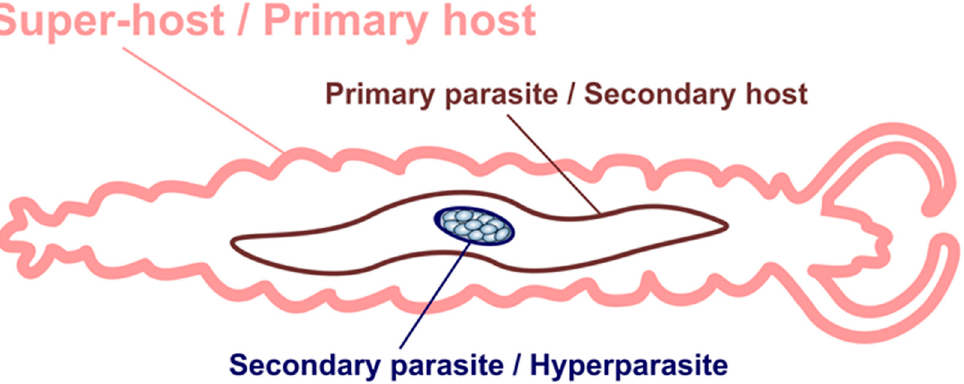
Figure 1. Schematic representation of a hyperparasitic system with the involvement of metchnikovellids. Polychaetes play the role of primary hosts or super-hosts. Gregarines act as primary parasites for polychaetes and secondary hosts for metchnikovellids at the same time. Metchnikovellids take the role of secondary parasites or hyperparasites.